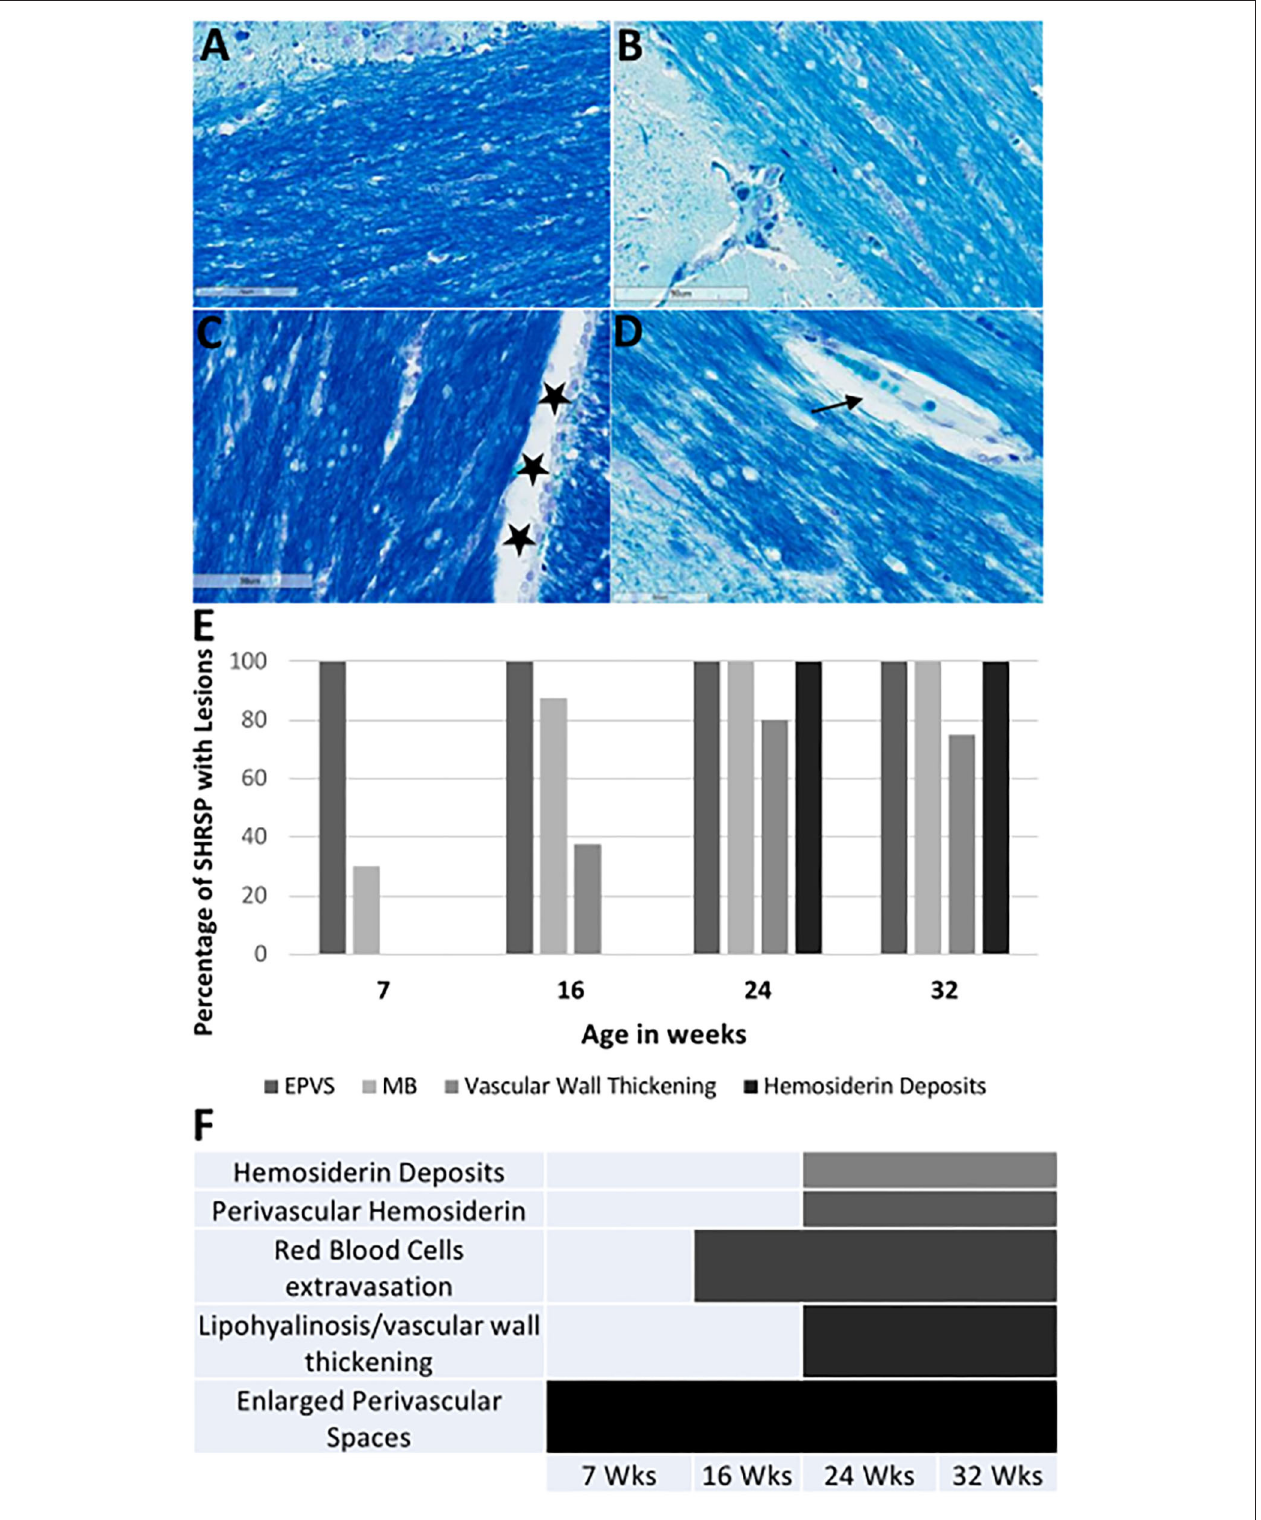
FIGURE 7 | Luxol fast blue (LFB) staining of the corpus callosum and the external capsule in WKY and SHRSP (A–D) at 40X magnification. Staining is negative for areas of demyelination. Normal view of the white matter is shown in WKY (A) and SHRSP (B) at 7 weeks of age. Stars in (C) shows an example of cerebral spinal fluid space dilation in a 32-week old WKY. We identified decrease in myelin in SHRSP surrounding the capillaries due to the expansion of the perivascular space [arrow in